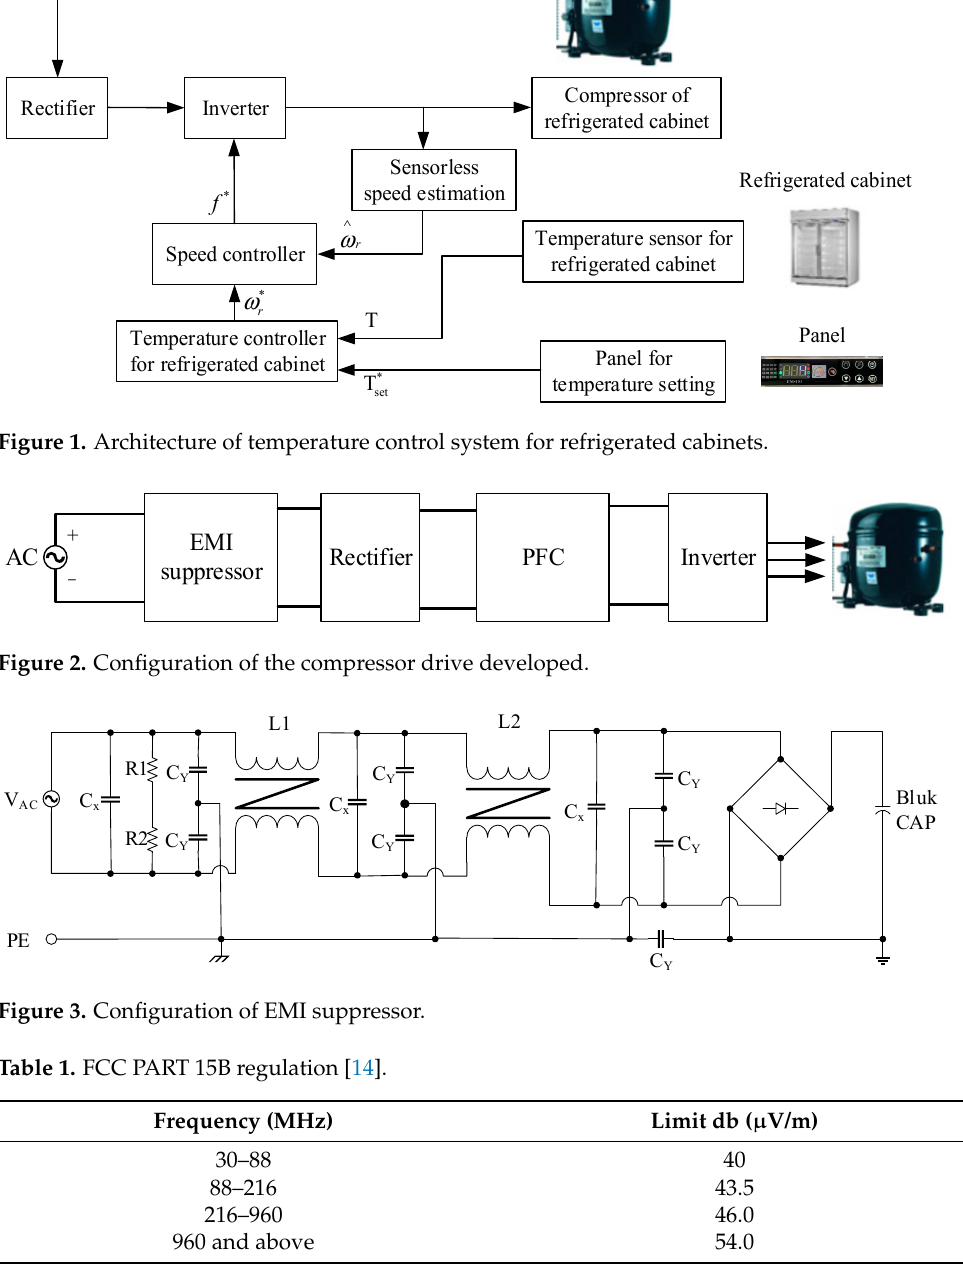
Figure 3. Configuration of EMI suppressor.